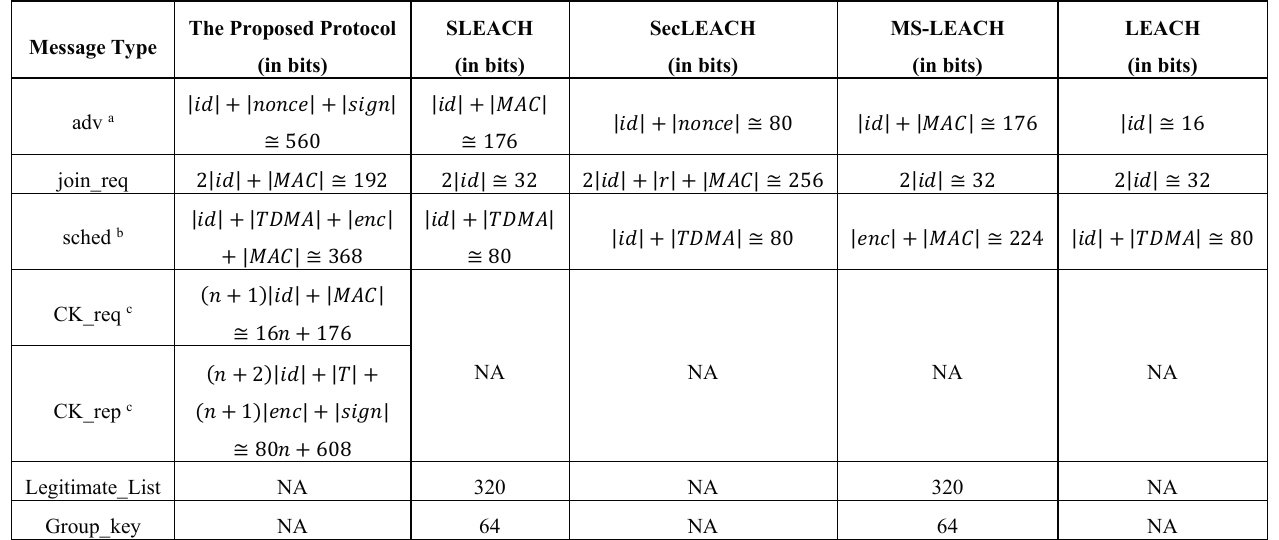
Table 6. Message size comparison for setup